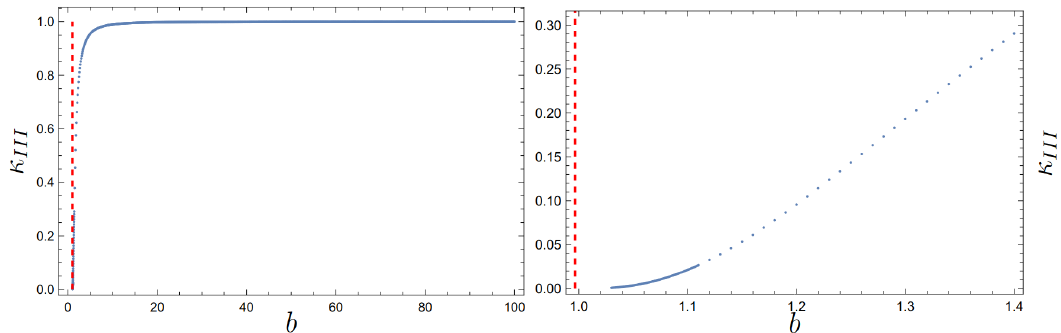
Figure 12 . The coefficient κ III , see (1.1), of the thermal order equation of state in the deformed Model III. The vertical dashed red line denotes b = b